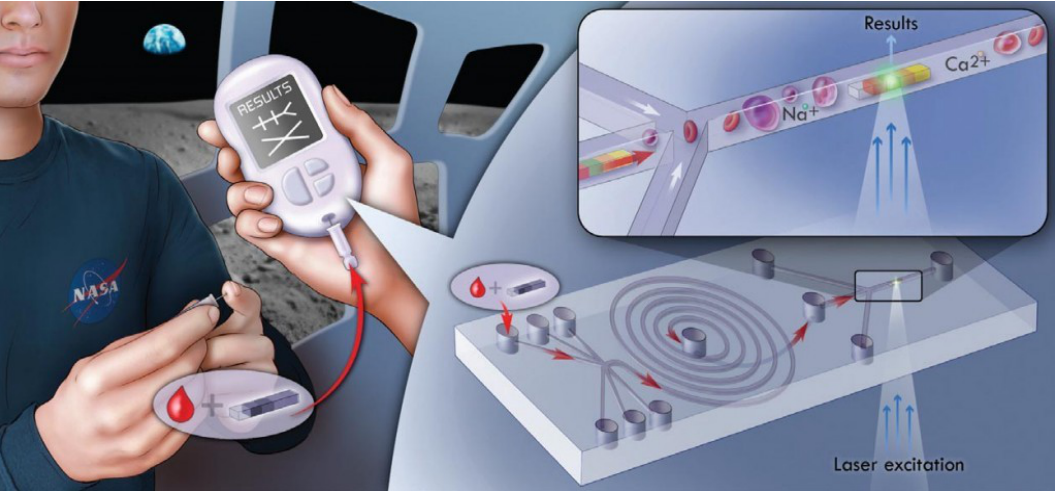
Figure 6. Point of Care Diagnostic Platform. The rHEALTH sensor is a self-contained, general-purpose device utilizing microfluidics and nanotechnology. It delivers multianalyte single molecule detection capabilities and provides demonstrated 100-fold better limits of detection (LOD) than current ELISA and bead-based immunoassay technology, with 896-fold